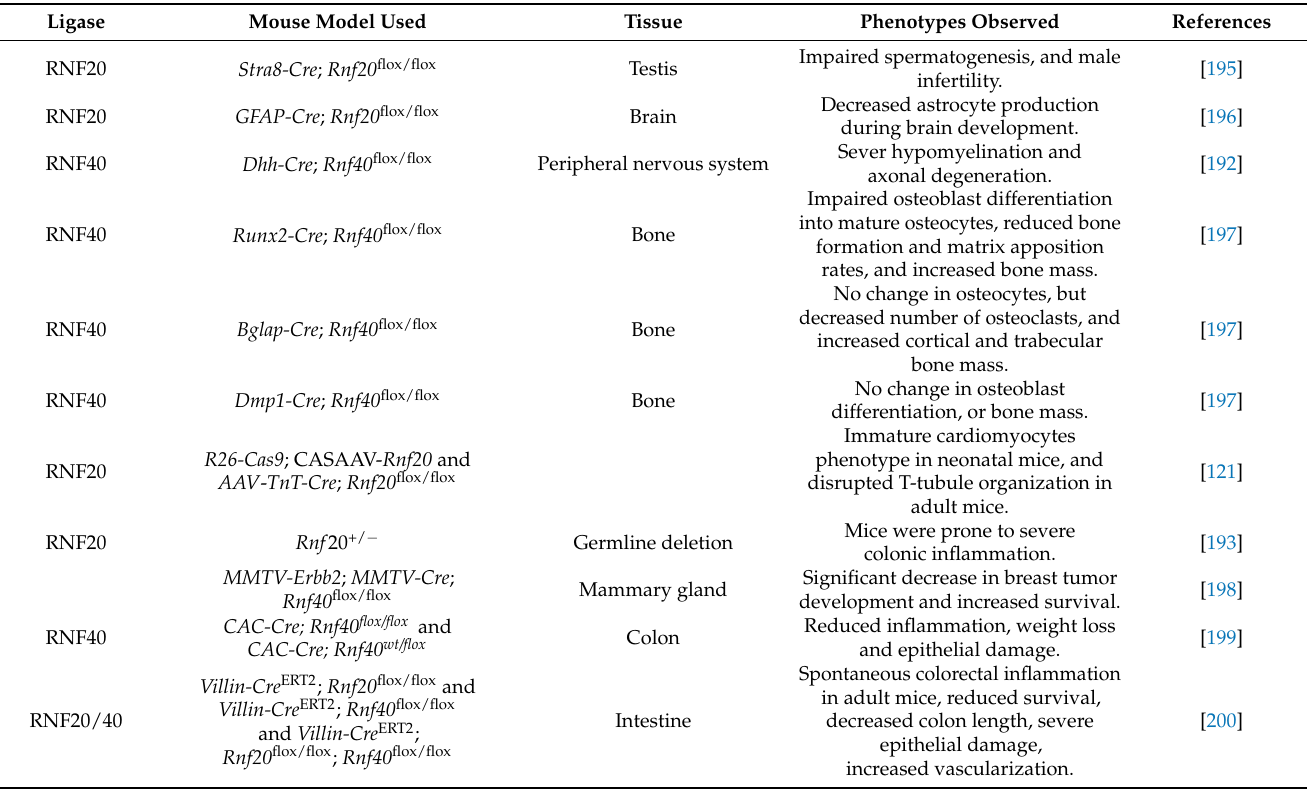
Table 2. Genetic mouse models of RNF20 and